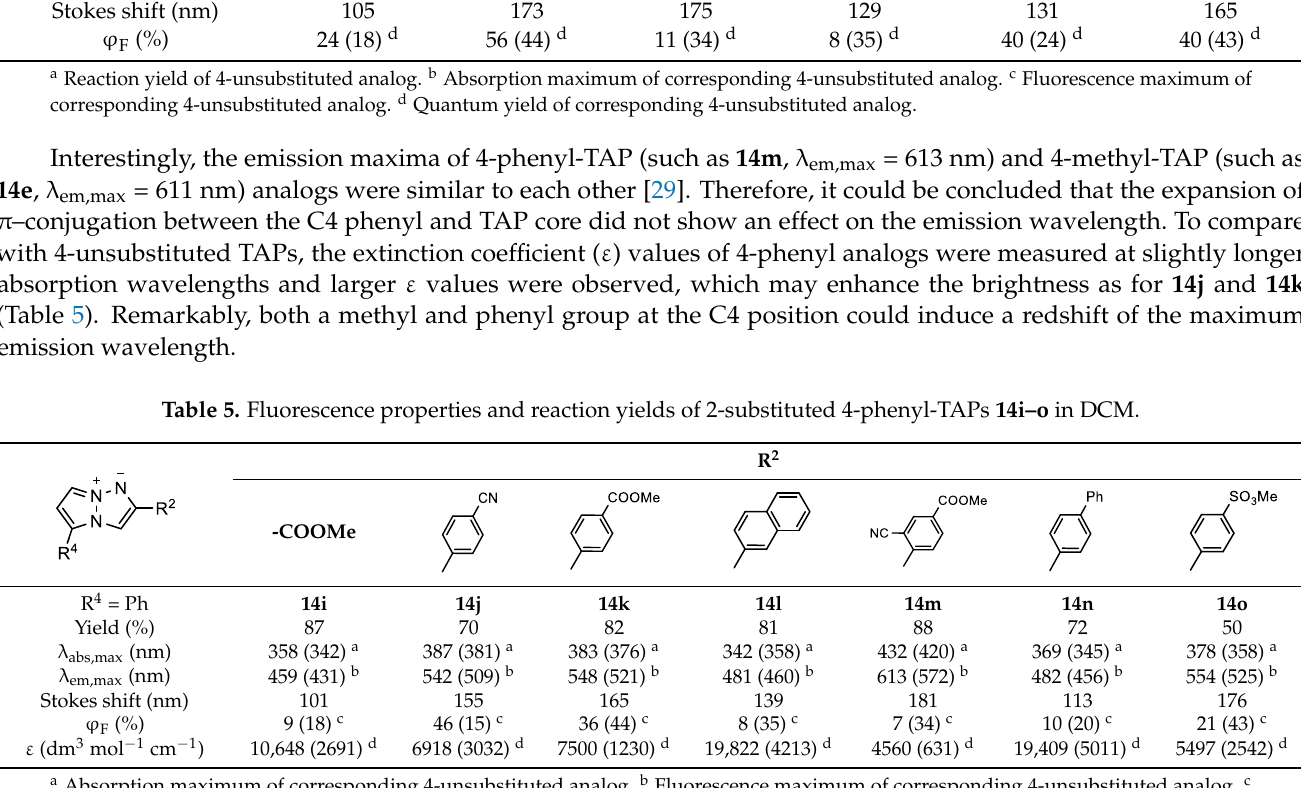
a Absorption maximum of corresponding 4-unsubstituted analog. b Fluorescence maximum of corresponding 4-unsubsti- tuted analog. c Quantum yield of corresponding 4-unsubstituted analog. d Extinction coefficient value of corresponding 4- unsubstituted analog.